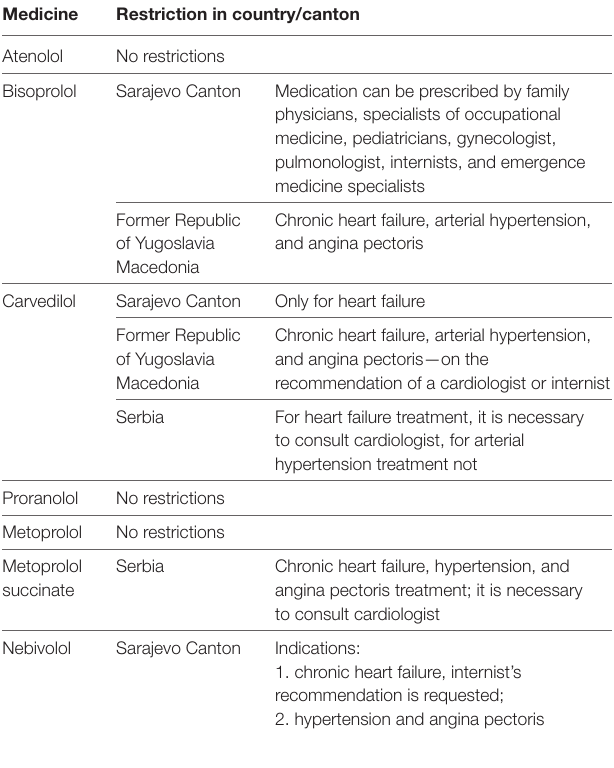
TaBle 2 | Prescribing-related restrictions for beta blockers in family practice.